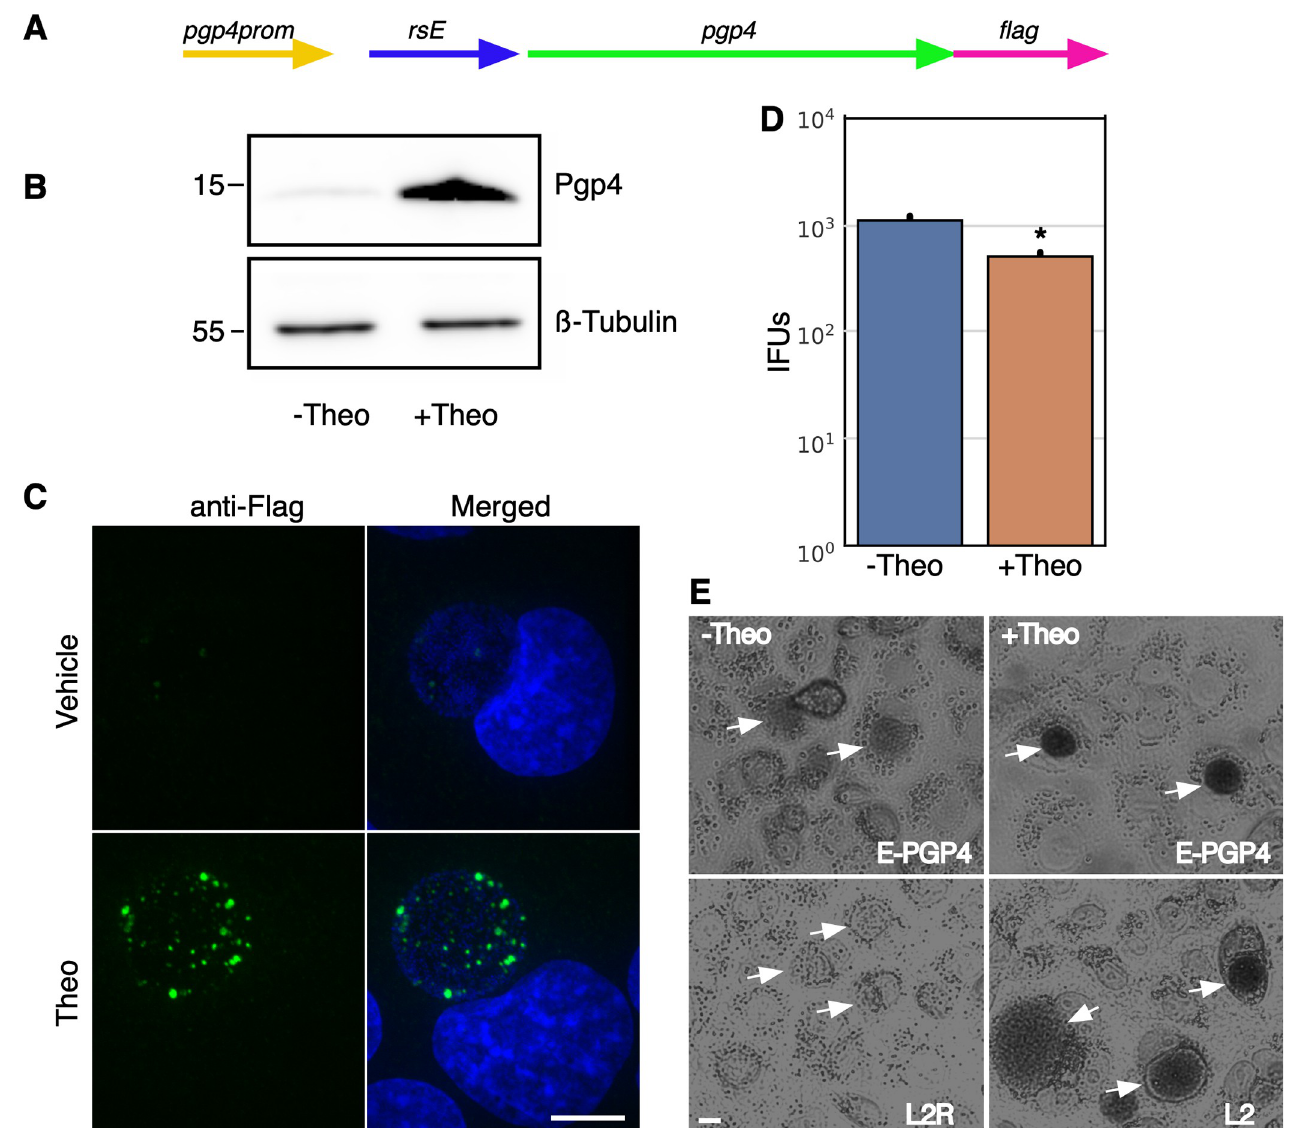
Fig 2. Characterization of p2TK2-SW2-nprom-E-pgp4-flag. A) Schematic of the nprom-E-pgp4-flag construct consisting of the native pgp4 promoter, the riboE riboswitch (rsE), and the pgp4 ORF with an inframe 3x flag tag. B) Anti-flag western blot of Cos-7 cells infected with L2-nprom-E-pgp4-flag comparing expression of theophylline treated and untreated cultures. Cells were induced or not with 0.5mM theophylline at 16 hpi and proteins were harvested at 30 hpi. A ß-tubulin I western blot served as a loading control. C) Confocal micrographs of Cos-7 cells infected with L2-nprom-E-pgp4-flag, induced or not with 0.5 mM theophylline at 16 hpi and fixed and stained with DAPI to detect DNA. The flag tag was detected using a primary antibody to the tag and an alexa 488 anti- mouse secondary antibody (green). Size bar = 10 μ m. D) Cos-7 cells were infected with L2-nprom-E-pgp4-flag and the production of infectious progeny was determined at 48 hpi after 0.5 mM theophylline induction or vehicle only. E) Iodine staining of glycogen in the inclusion of Cos-7 cells infected with L2-nprom-E-pgp4-flag after 0.5 mM theophylline induction at 16 hpi or vehicle only. Arrows indicate the location of the chlamydial inclusions. Asterisk denotes p-value < 0.05. Error bars =